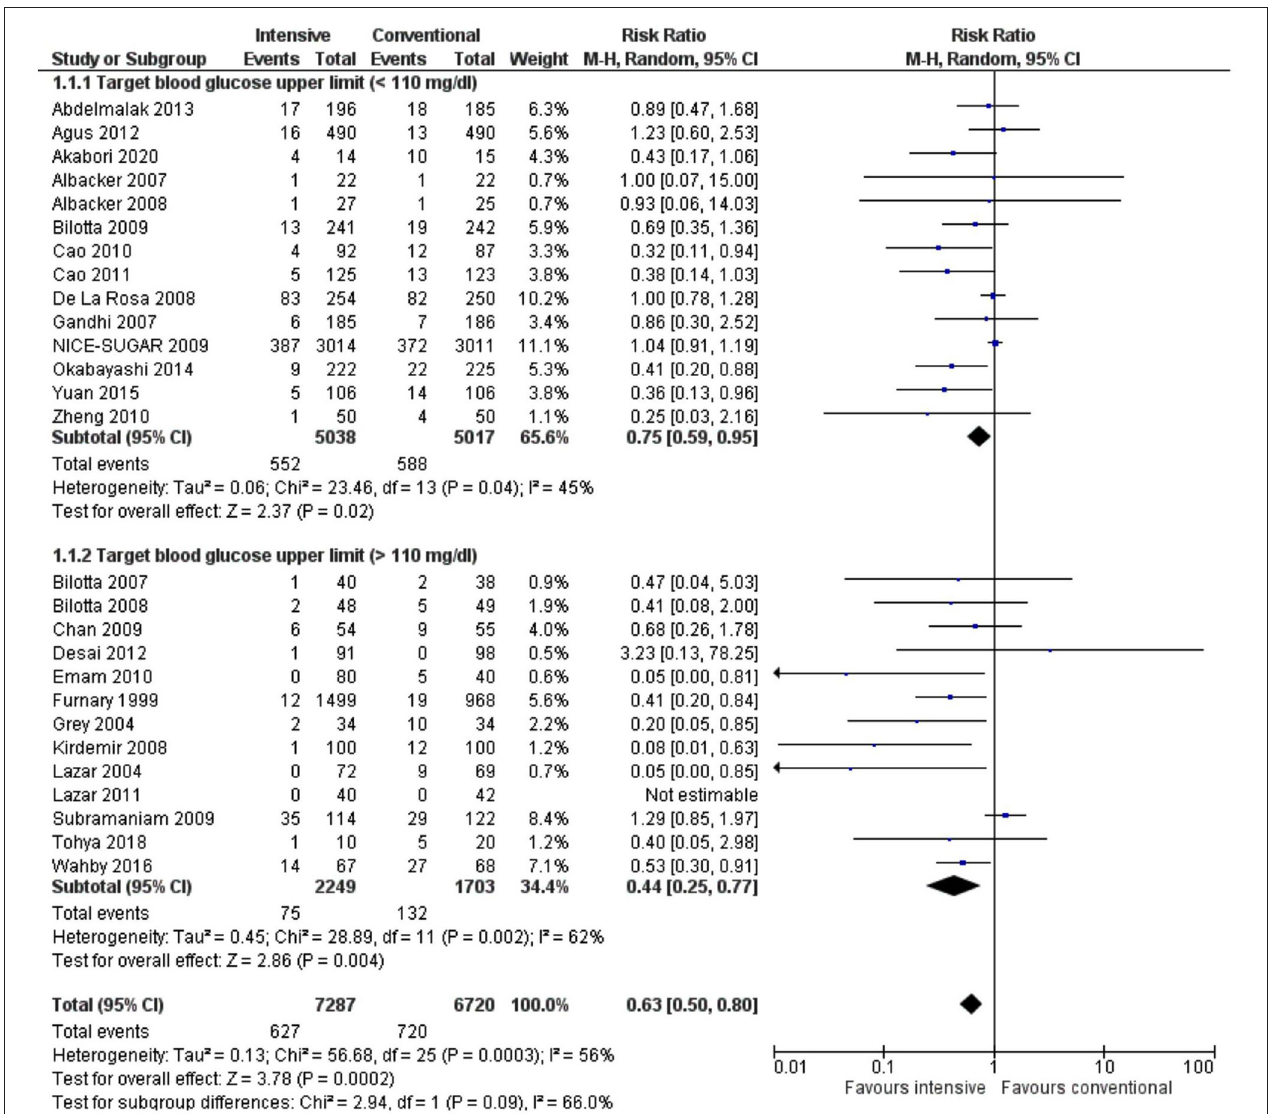
FIGURE 4 | A forest plot for a subgroup analysis of target blood glucose level in the intervention group in studies using a random-effects model. Risk ratios (RRs) and 95% CIs are shown.